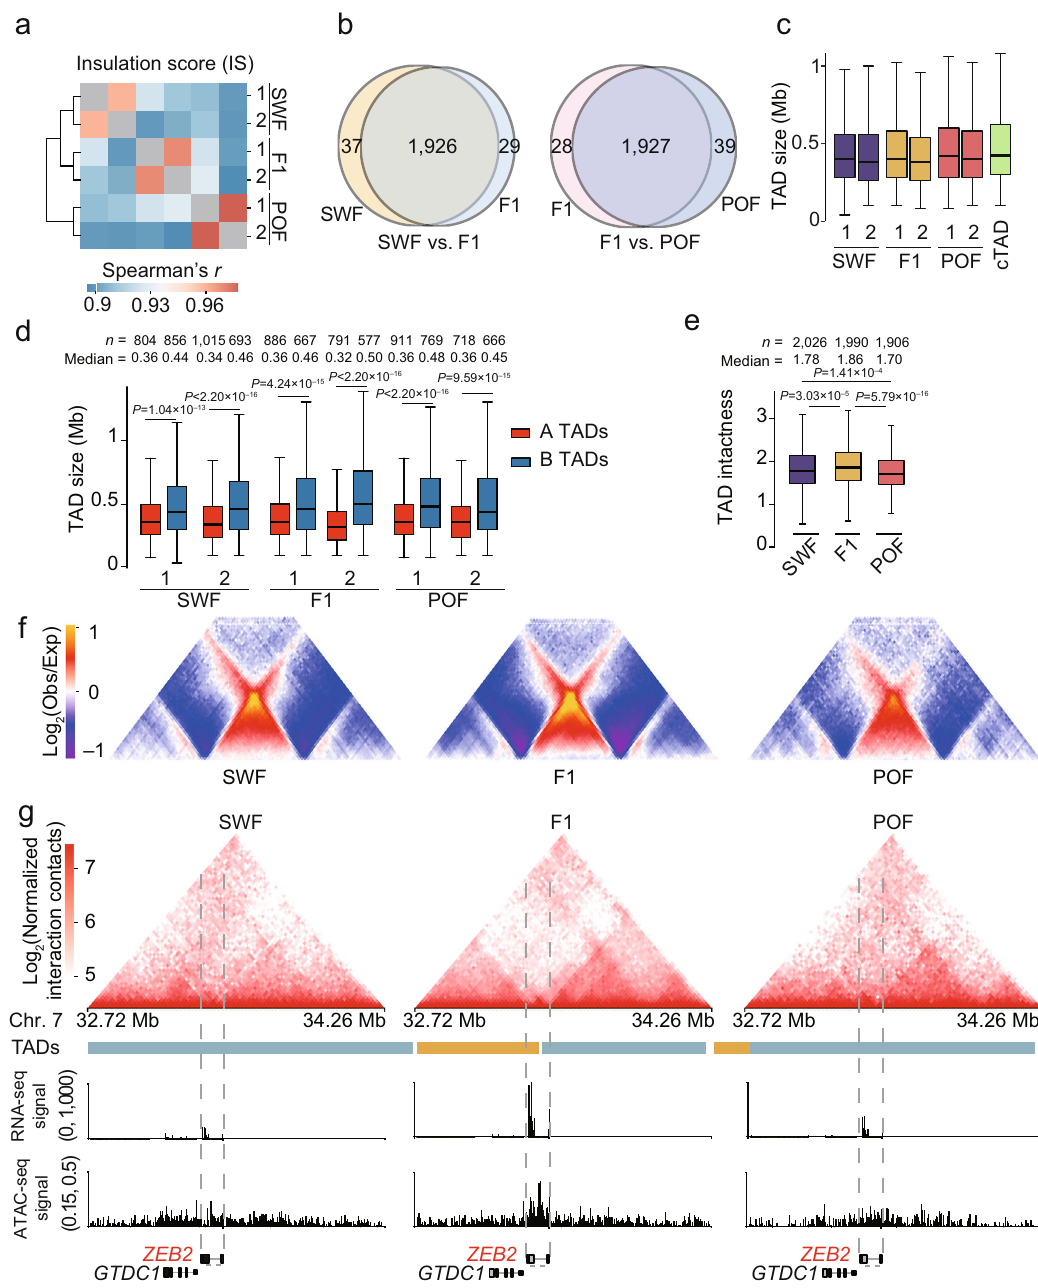
Fig. 4 TAD boundaries are largely stable in chicken granulosa cells during folliculogenesis. a Spearman ’ s r heatmap of the insulation score (IS) at different developmental stages. b Overlap of TAD boundaries between successive stages of follicle development. c Boxplots showing TAD sizes in GCs during folliculogenesis, where cTADs represent consensus TADs. d Comparison of TAD size for A and B TADs. e TAD intactness at each stage. f Examples of average TAD representation with intra- or inter-TAD contact in SWF, F1 and POF respectively. g Changes in TAD boundaries and expression levels at the locus of ZEB2 gene (red) across different developmental stages. Top: Hi-C contact heatmaps of the genomic region around ZEB2 (Chr.7: 32.72 – 34.26 Mb). Middle: TAD boundaries and genome browser tracks of gene expression and ATAC-seq signals. Bottom: gene structures in the genomic region. The dashed line boxes indicate the chromosomal locations of the genes. For c , d and e , the internal line indicates the median, the box limits indicate the upper and lower quartiles and the whiskers extend to 1.5 IQR from the quartiles. P values in d and e were calculated using two-sided Wilcoxon rank- sum test. Source data are provided as a Source Data fi